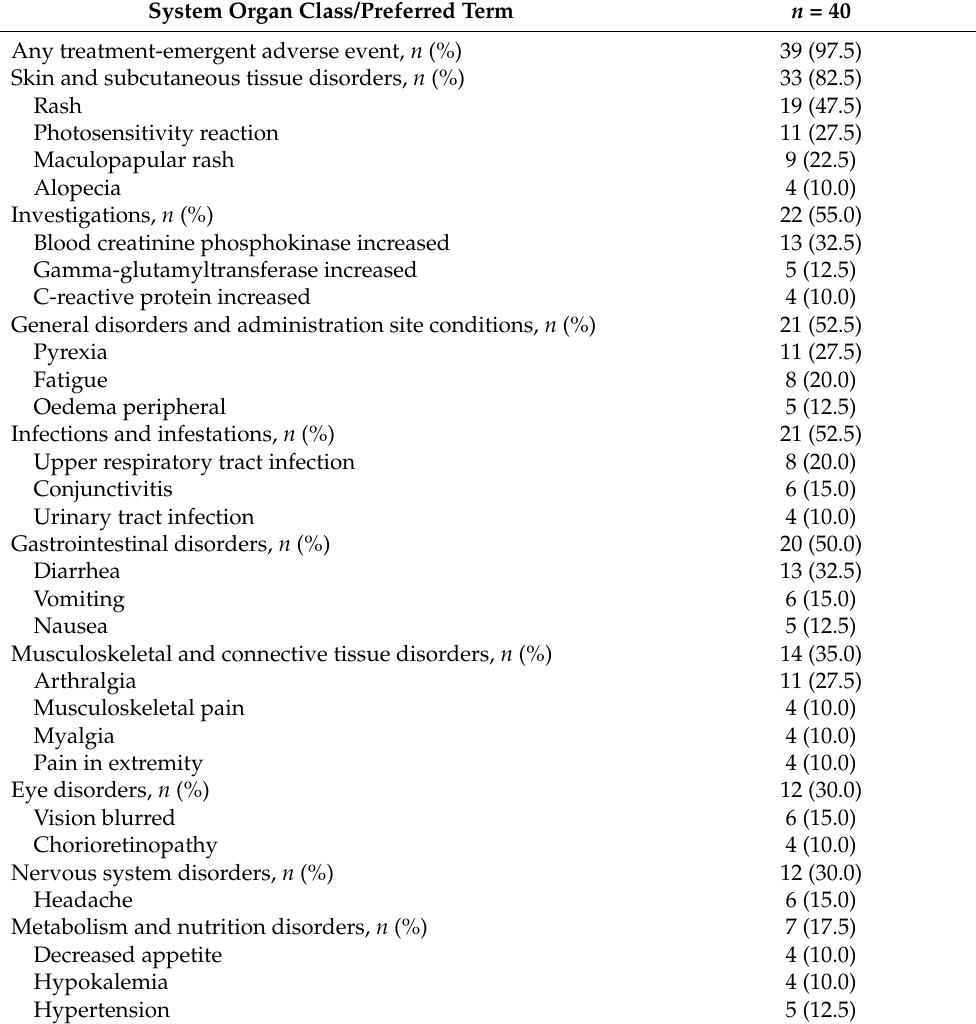
Table 4. Common treatment-emergent adverse events (incidence ≥ 10% by preferred